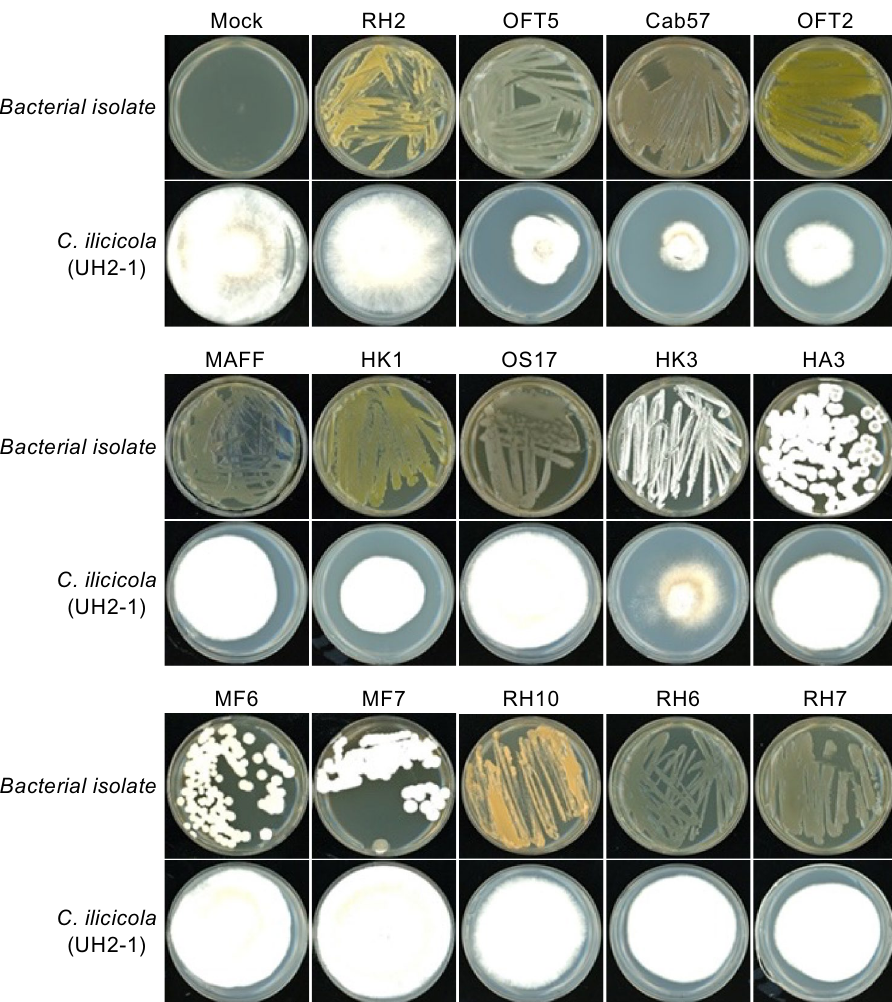
Figure 1. Suppressive effects of endophytic and rhizosphere bacteria on Calonectria ilicicola (UH2-1) mycelial growth determined using the double-plate chamber method. The plate images were taken 14 days after incubation. The growth inhibition rates (%) against nine different C. ilicicola isolates are shown in the Table